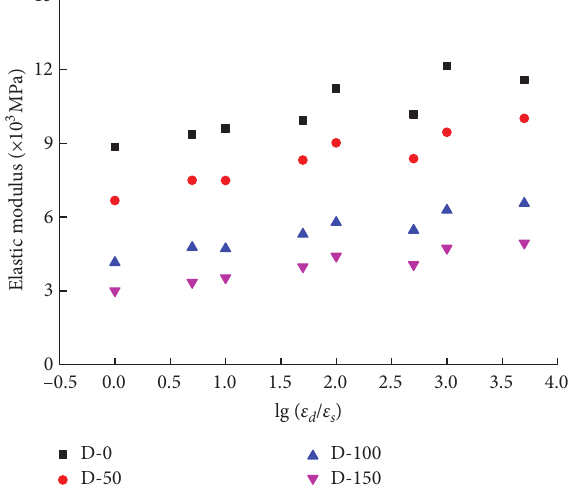
Figure 10: The effect of strain rate on the elastic modulus.